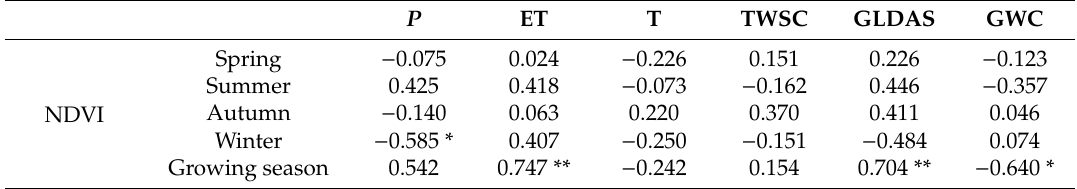
Table 4. Correlation between NDVI and hydrological factors in di ff erent